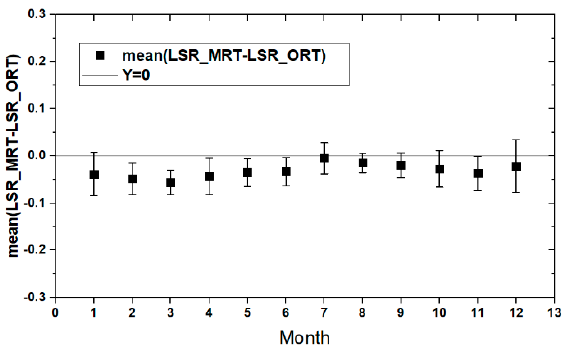
Figure 8. The monthly averaged difference in LSR between MRT and ORT.